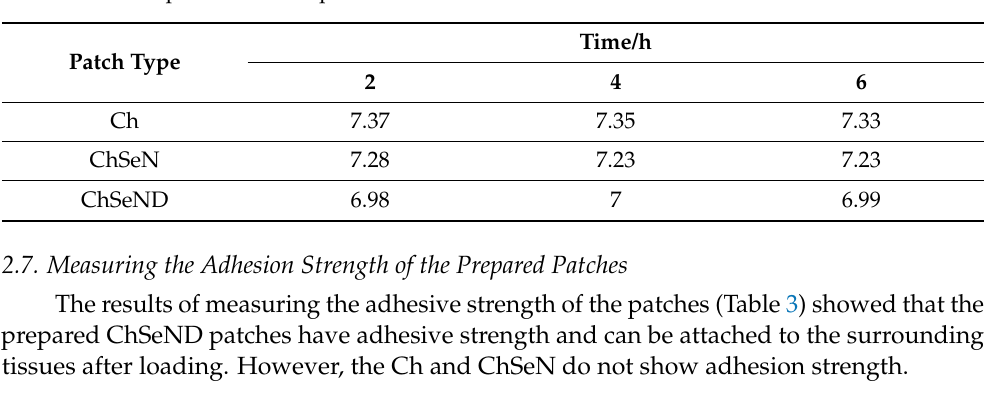
Table 2. Surface pH of different patches at determined